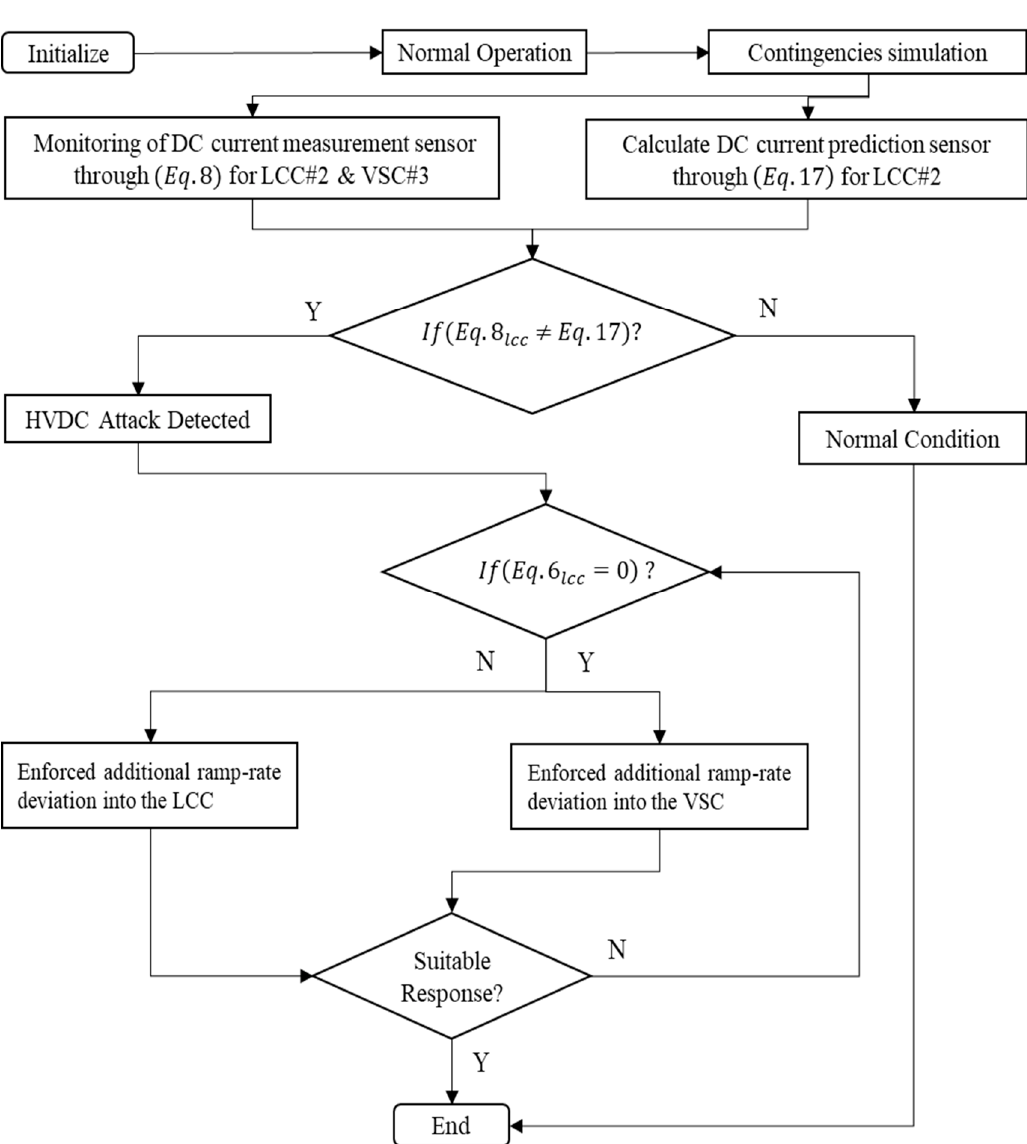
Figure 12. Algorithm of cyber attack mitigation control.